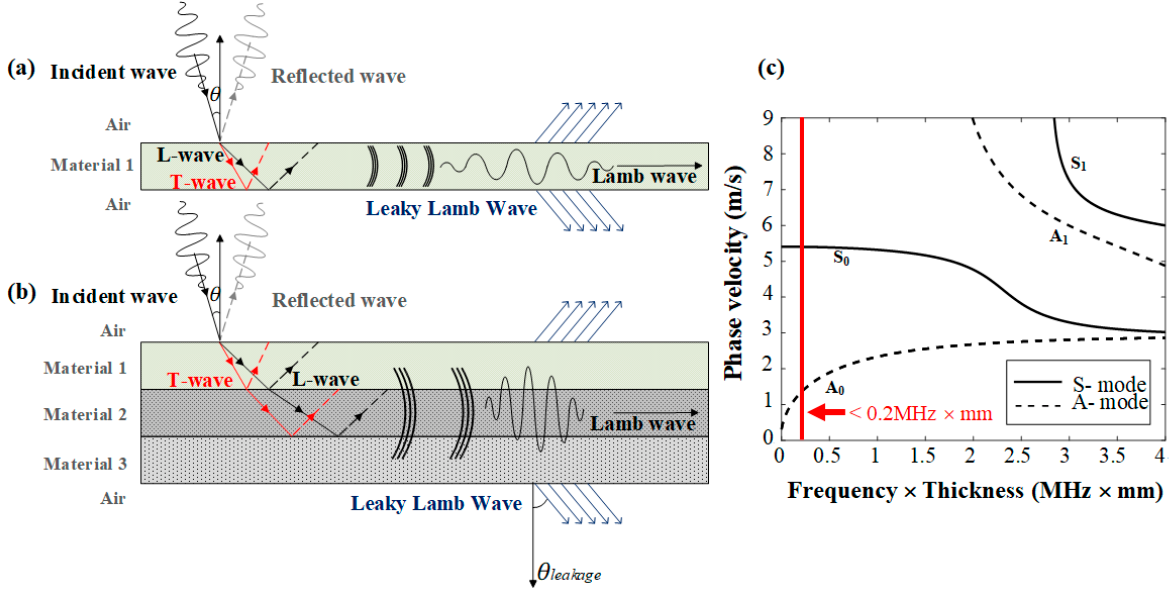
Figure 1. Illustration of Lamb wave generation, propagation, and leakage in ( a ) a single plate and ( b ) a multi-layered structure. ( c ) The phase velocity dispersion curve in Al [21].